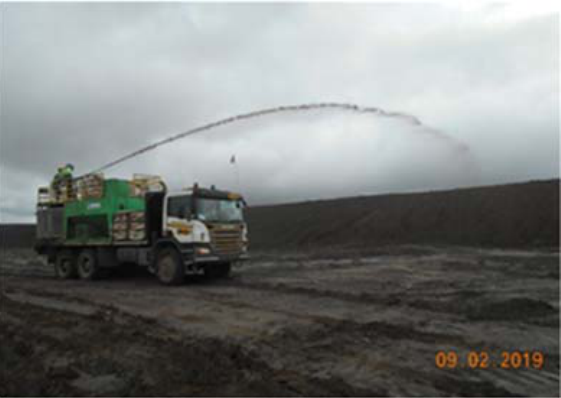
Figure 6. Hydroseeding application on post-coal-mining landscapes.